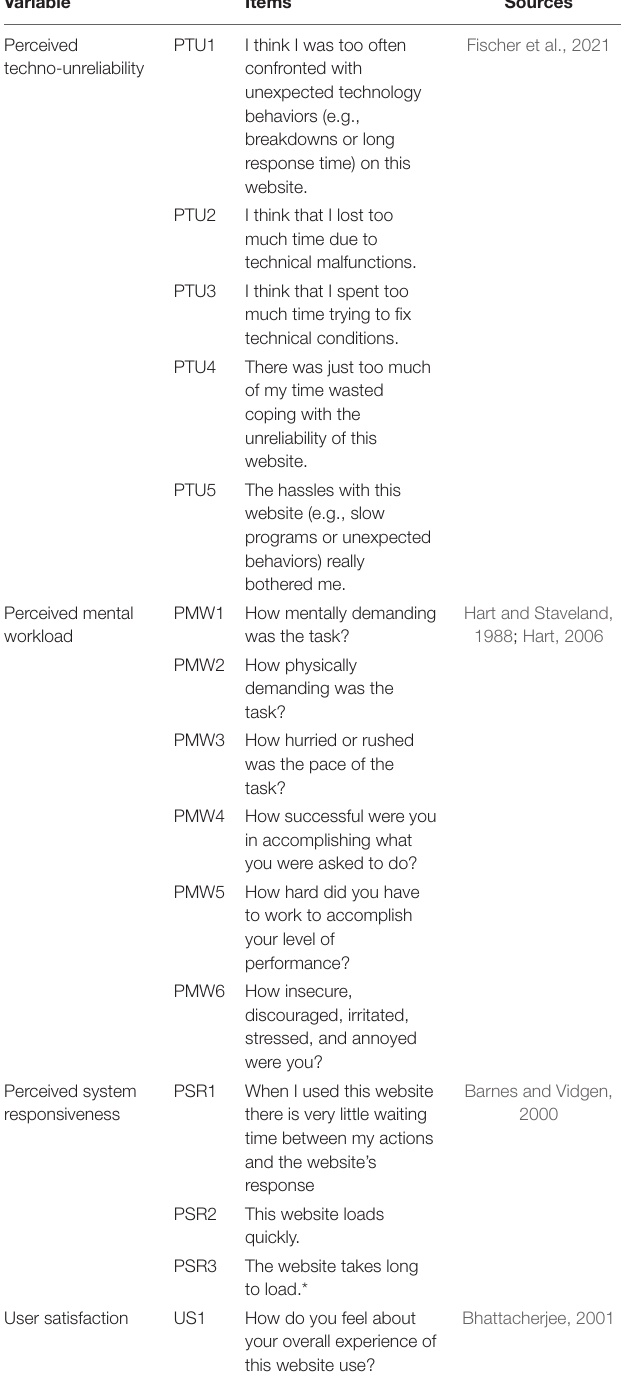
TABLE 1 | Measurement items of self-reports